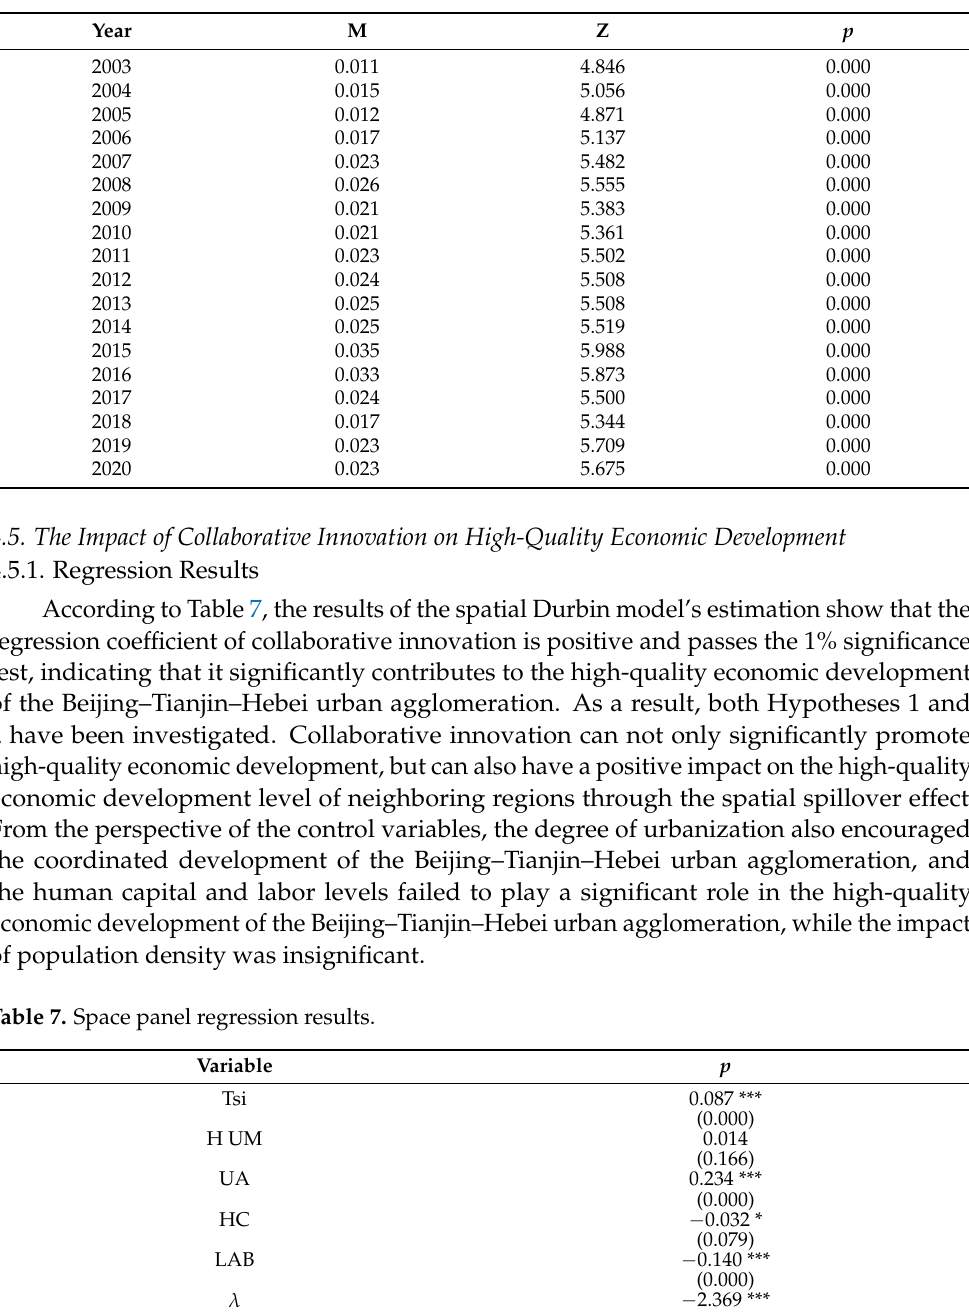
Table 6. α = 0.9 Moran’s I index test results.